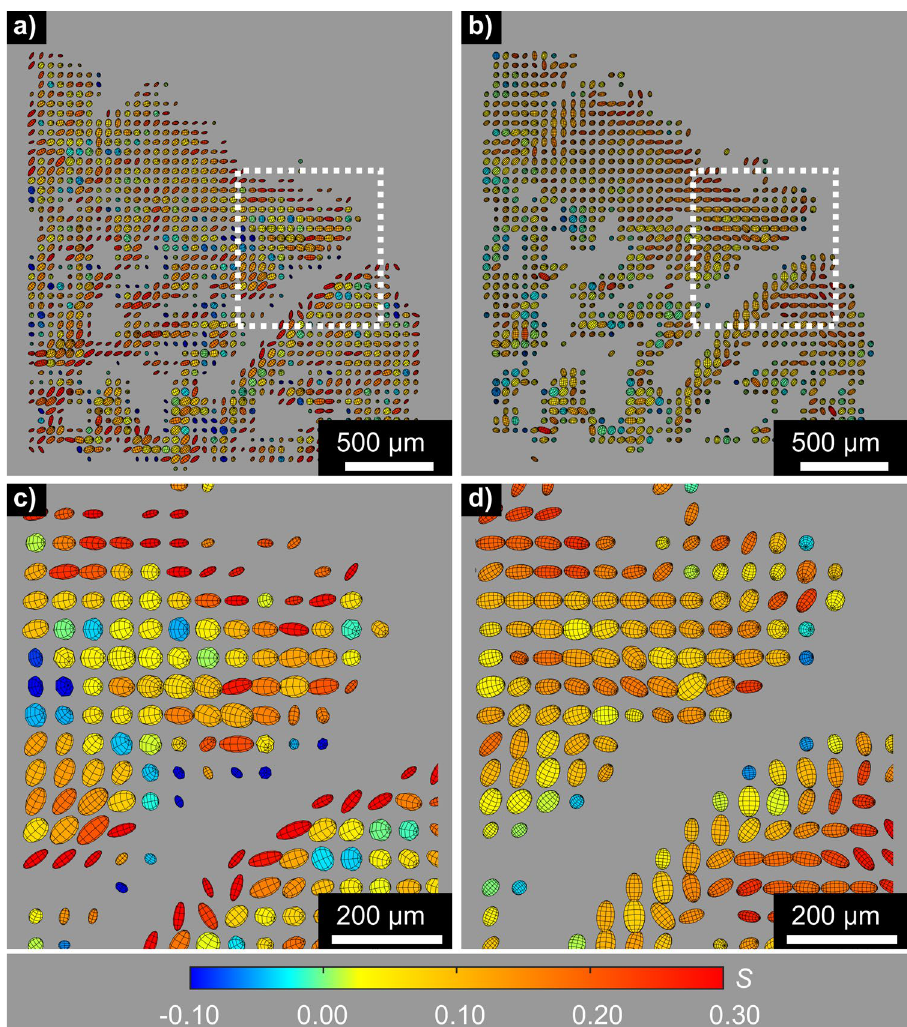
Figure 4. Comparison of (a,c) XRDTT based on HA002, and (b,d) SASTT. The depicted cross-sections show the same region as in Figs. 2a and 3a. (c,d) are magnified sections of (a,b) , respectively. The preferred HA crystallite orientation direction associated with each voxel is indicated by ellipsoids. The shape elongation and colours are scaled by the Hermans’ parameter S and the volume is scaled by the scattered intensity. Note the systematic differences between the reconstructions, most markedly towards the